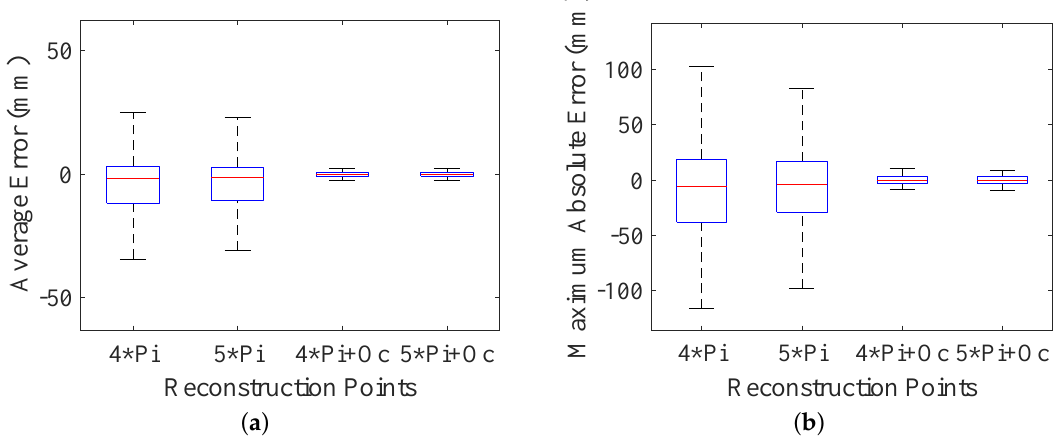
Figure 8. Pose error using different numbers of reconstruction points: ( a ) angular error of direction; ( b ) position